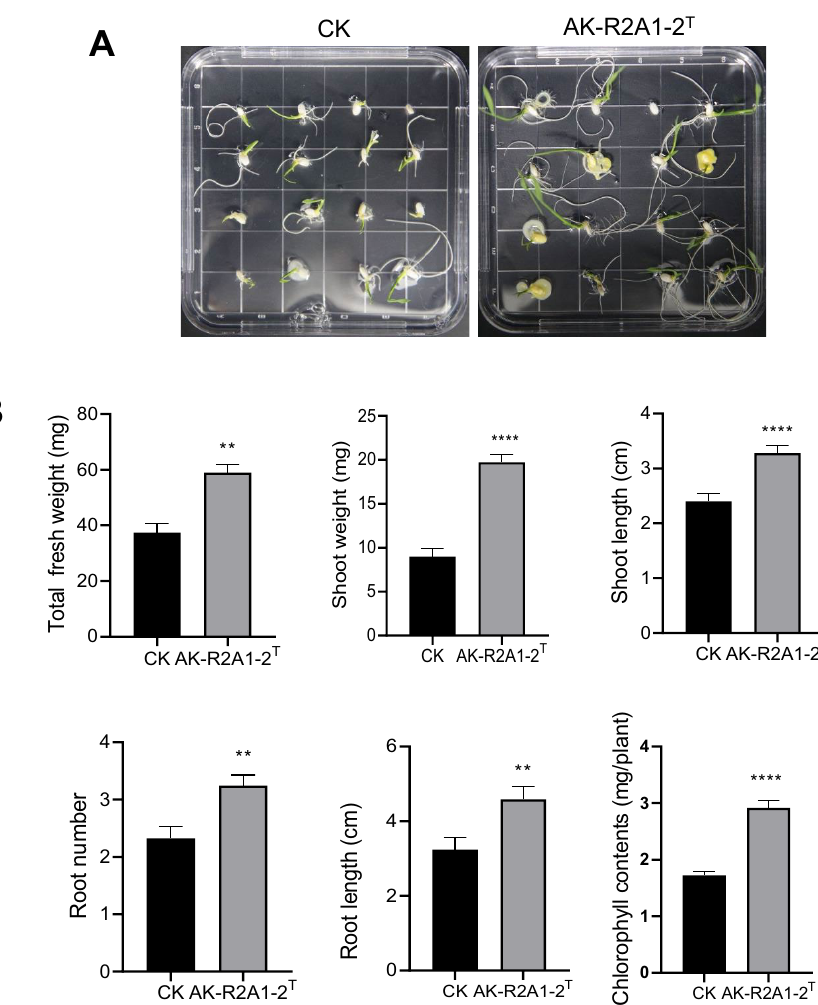
Figure 4. Effects of coating strain AK-R2A1-2 T on rice growth under low temperature. ( A ) Comparison of rice seedling growth in response to a control (CK, R2A broth) or AK-R2A1-2 T bacterial suspension (1 × 10 8 cfu/ mL) on water agar plates at 20 °C for 10 days. ( B ) Quantification of total fresh weight, shoot weight, shoot length, root number, root length, and chlorophyll contents. Error bars indicate the standard deviation of the mean ( n = 15). Asterisks indicate a statistically significant difference between the control and coating bacterial suspension (two-way ANOVA, ** p < 0.01, and **** p < 0.0001). Experiments were repeated twice with similar